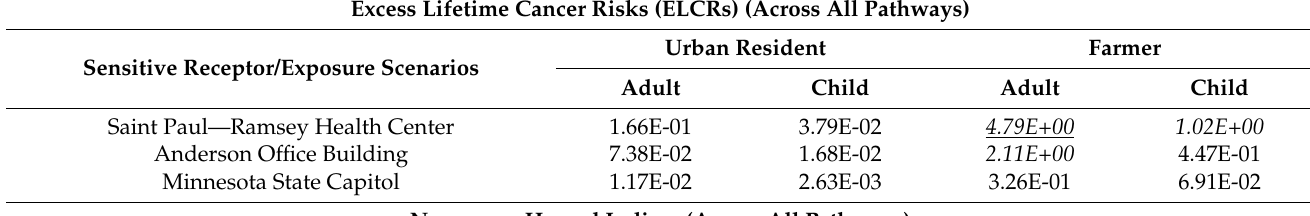
Table 14. Normalized Cumulative Excess Lifetime Cancer Risks and Chronic Noncancer Hazards.